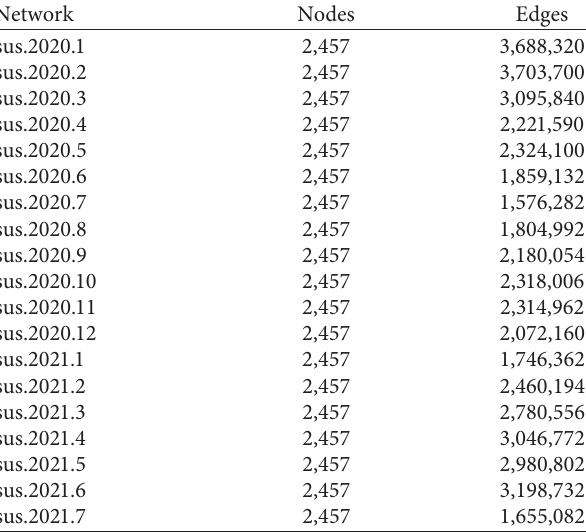
Table 1: Main characteristics for deaths networks. Network Nodes Edges